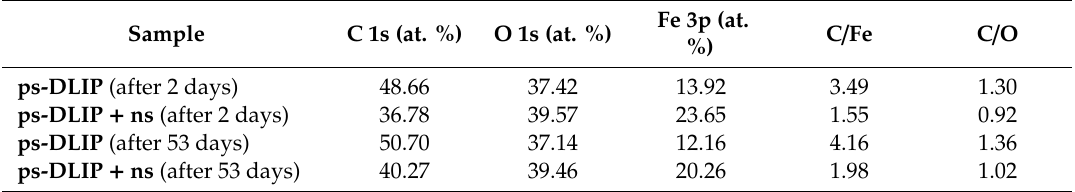
Table 2. Surface composition (at. %) of the multi-scale (ps-DLIP) and single-scale (ps-DLIP + ns) after 2 days and 53 days measured by XPS. Sample